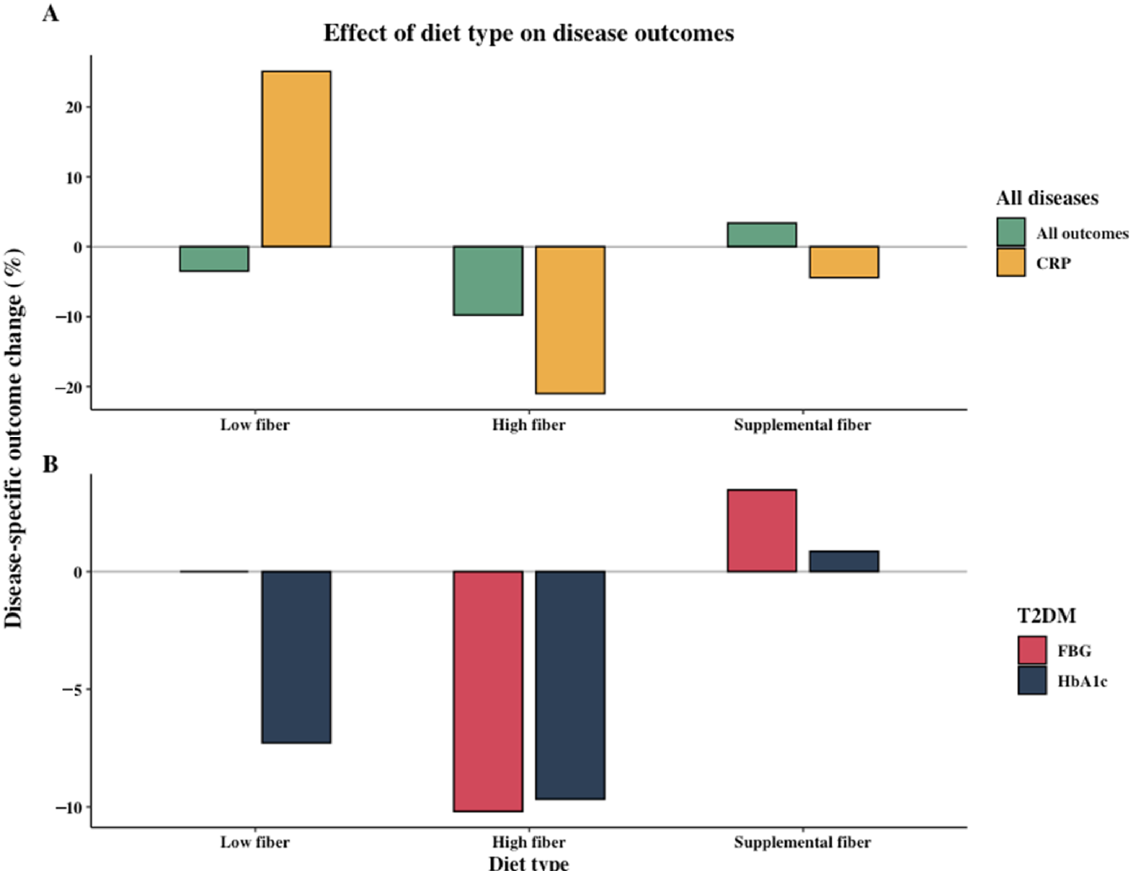
Figure 3. Effect of diet type (low fiber, high fiber, and supplemental fiber) on disease-specific outcomes for ( A ) all diseases combined and ( B ) Type 2 diabetes (T2DM). Percentage relative change between intervention group and control group or end intervention and baseline is shown. Averages are weighted based on number of participants in the intervention group. Statistical significance of outcomes not incorporated. ( A ) All disease outcomes (low fiber: 2 studies, n = 46; high fiber: 12 studies, n = 180; supplemental fiber: 11 studies, n = 246); C-reactive protein (CRP) (low fiber: 1 study, n = 24; high fiber: 7 studies, n = 105; supplemental fiber: 5 studies, n = 136). ( B ) Fasting blood glucose (FBG) (low fiber: 0 studies, n = 0; high fiber: 4 studies, n = 72; supplemental fiber: 6 studies, n = 150); Hemoglobin A1c (HbA1c) (low fiber: 1 study, n = 25; high fiber: 4 studies, n = 72; supplemental fiber: 6 studies, n = 163).